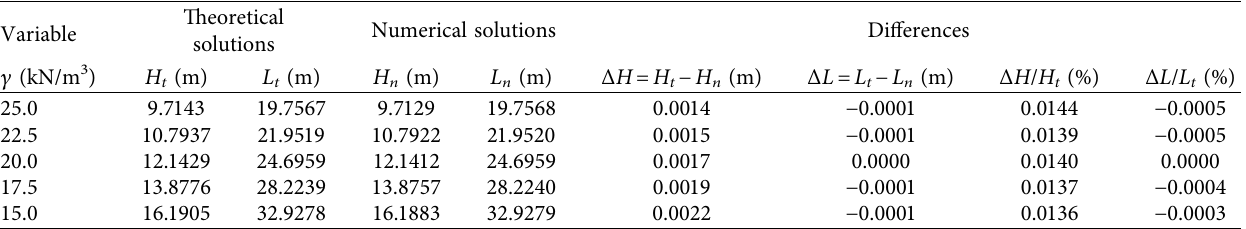
Table 4: Comparison of height H and width L of collapse block between theoretical solutions and numerical solutions with varied parameter c . Variable